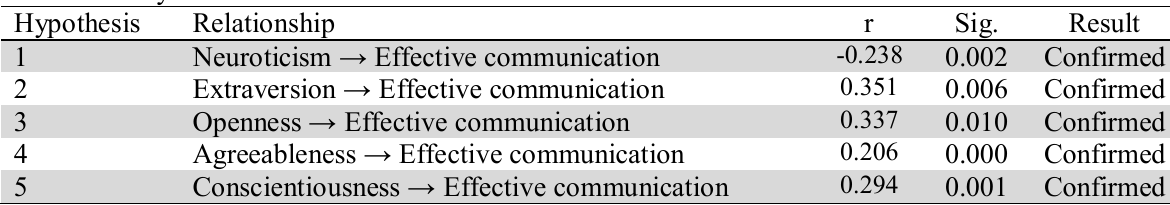
The summary of Pearson correlation ratio